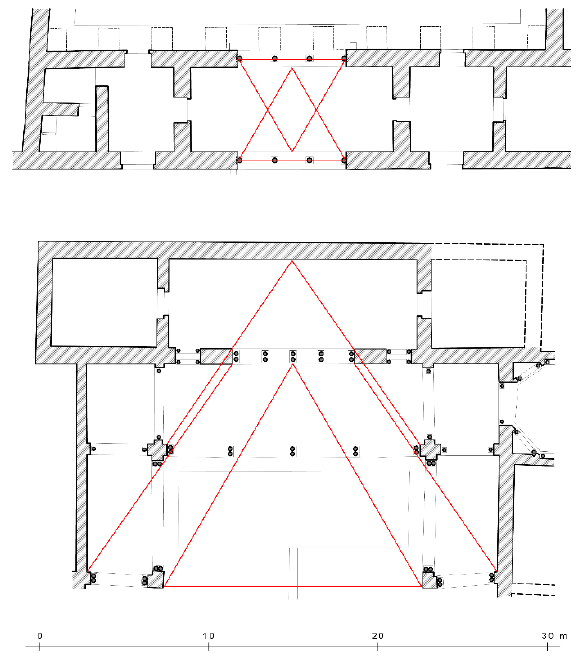
Figure 7. Application of equilateral triangles to the design of arcade openings: western hall of al-Rumm ā n ī ya in Córdoba ( top ); northern hall of the Aljafería in Zaragoza ( bottom ). Drawings by Felix Arnold.